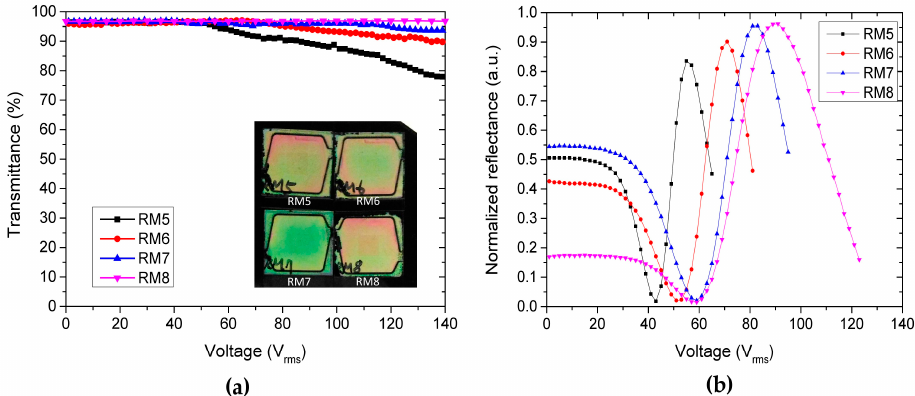
Figure 3 . Measurements of transmittance and reflectance with respect to applied voltages in completed PNLC cells with various RM257 concentrations: ( a ) the measurements of transmittance versus applied voltages. The inserts show optical observations of four completed PNLC cells via the light box with a pair of crossed polarizers; ( b ) the measurements of normalized reflectance curves versus applied voltages in the same cells via the setup shown in Figure 2.